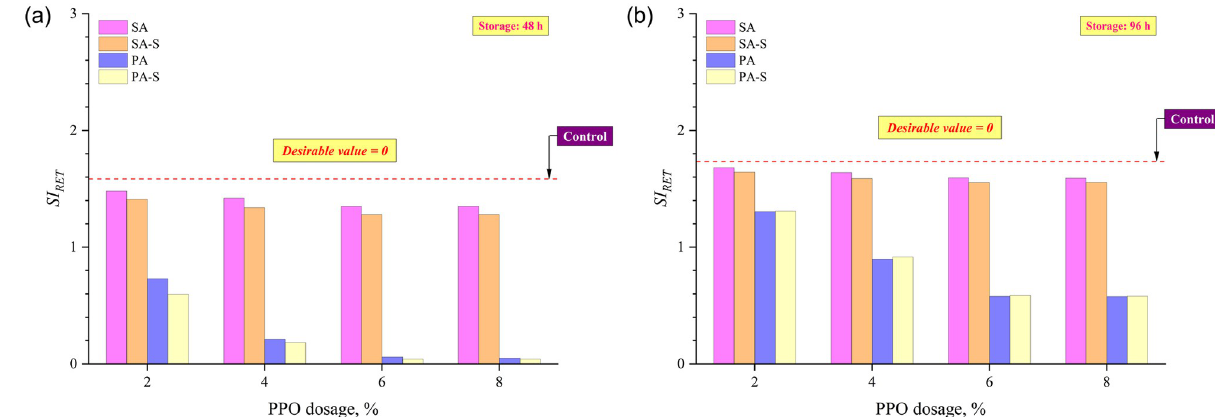
Fig 13. SI results from rubber extraction test after (a) 48 h and (b) 96 h of thermal storage. RET